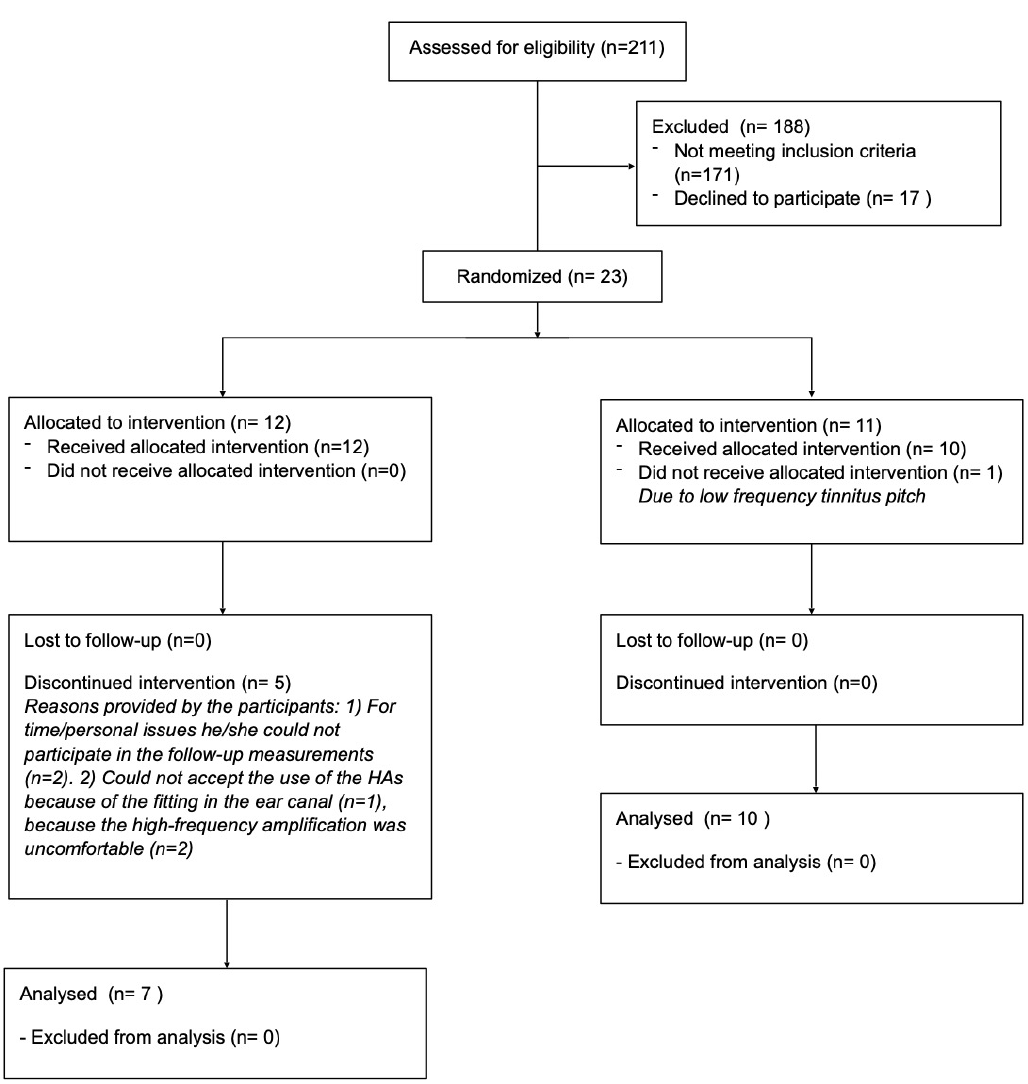
Figure 1. Overview of the participant selection.